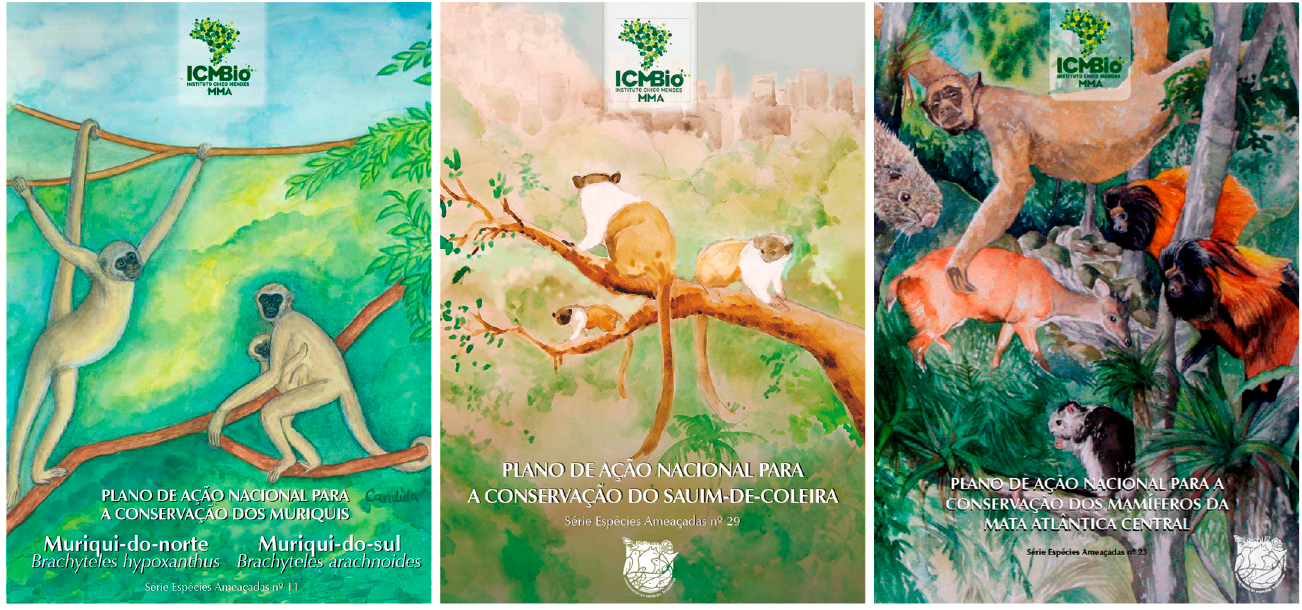
Figure 3. Covers from some national conservation action plans focusing on primates published by the Brazilian federal environmental agency, ICMBio. Plans pictured (left to right): Jerusalinksy et al. [41], Jerusalinsky et al. [42], and Escarlate-Tavares et al. [43].